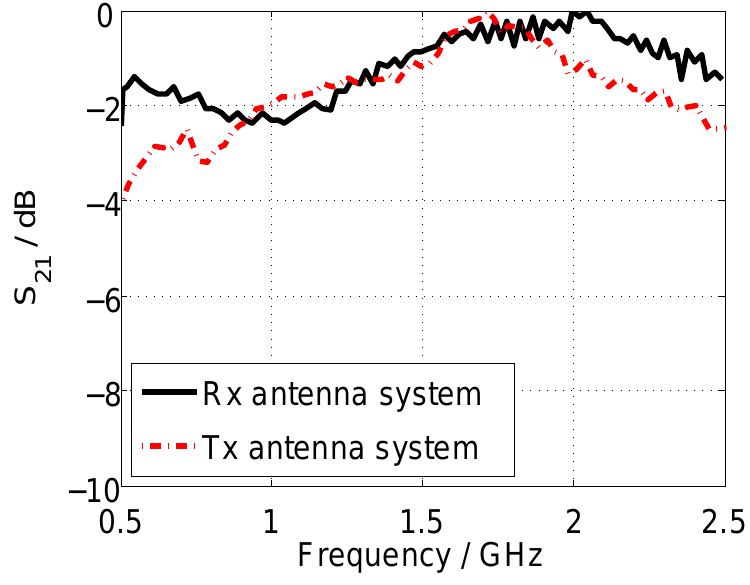
Figure 5. Frequency characteristics of the fiber-coupled active antenna system: Rx antenna (black, solid), Tx antenna (red,